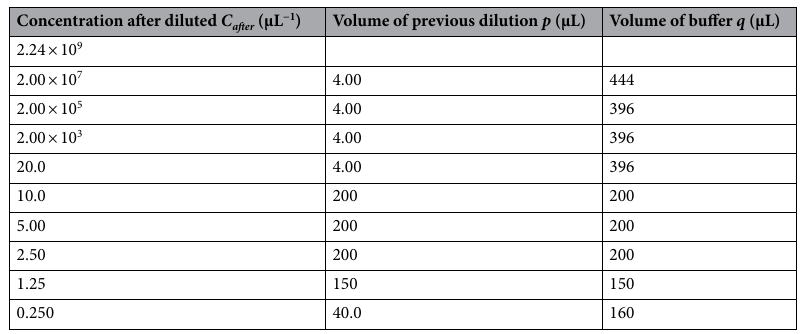
Table 6. Protocol of serial